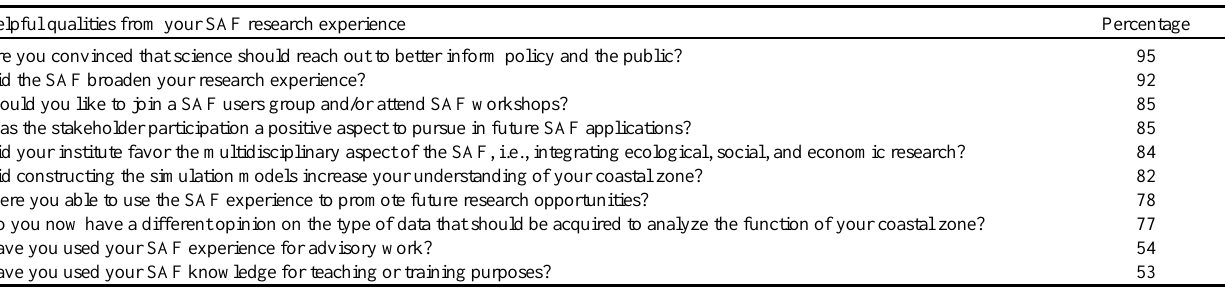
Table 2. Results of a questionnaire distributed to the authors participating in the study sites (n = 29) on how the experience of the SAF applications influenced their